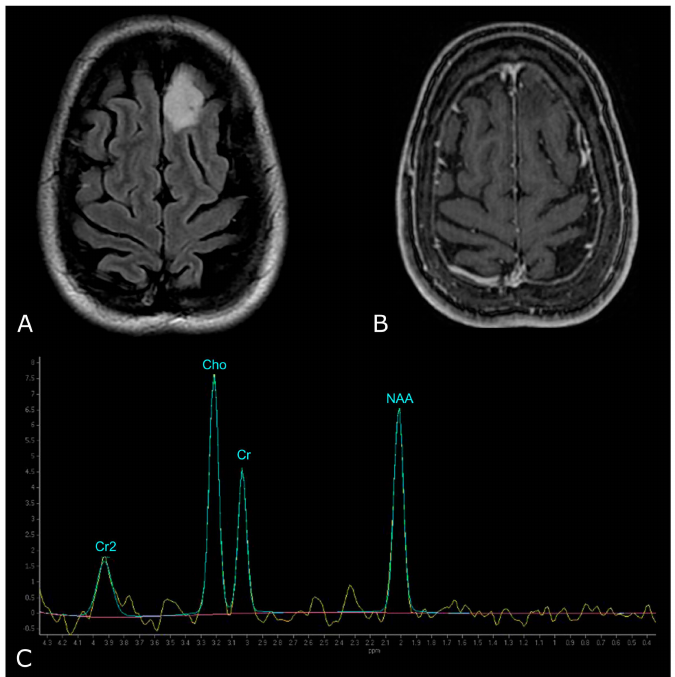
Figure 9. MR Spectrum of LGG (SV TE 144ms). ( A , B ) Axial T2-FLAIR and post-contrast T1w of a left frontal low grade IDH-mut and 1p/19q-codeleted OD. ( C ) SV MRS demonstrates moderate Cho elevation and NAA reduction.